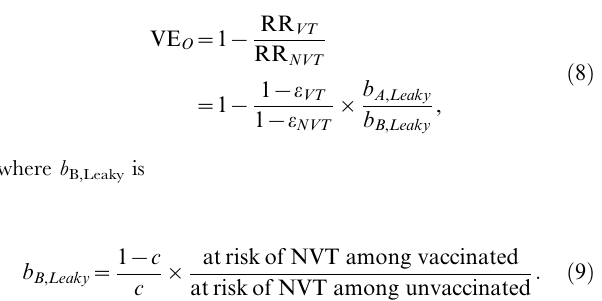
Figure 2. Vaccine effectiveness in the SIR (Susceptible-Infectious-Recovered) model. Field estimate (vertical axis) represents the vaccine effectiveness estimate derived from empirical observation in the field. Solid line represents vaccine effectiveness based on odds ratio, VE O , while broken line represents that based on relative risk, VE R . Assumed vaccine efficacy against VT (vaccine type) is shown at the right end of each line. Cross-protective immunity is expressed as perfect protection with a probability s for an all-or-nothing type vaccine, and expressed as the relative reduction in the instantaneous risk of infection upon exposure against a serotype among those who have already experienced infection with the other serotype for a leaky type vaccine. (a)-(c) show the effectiveness of all-or-nothing vaccine (i.e. perfect protection given successful immunization and no protection for unsuccessful vaccination), whereas (d)-(f) show the effectiveness of leaky vaccine (i.e. imperfect protection for all vaccinated